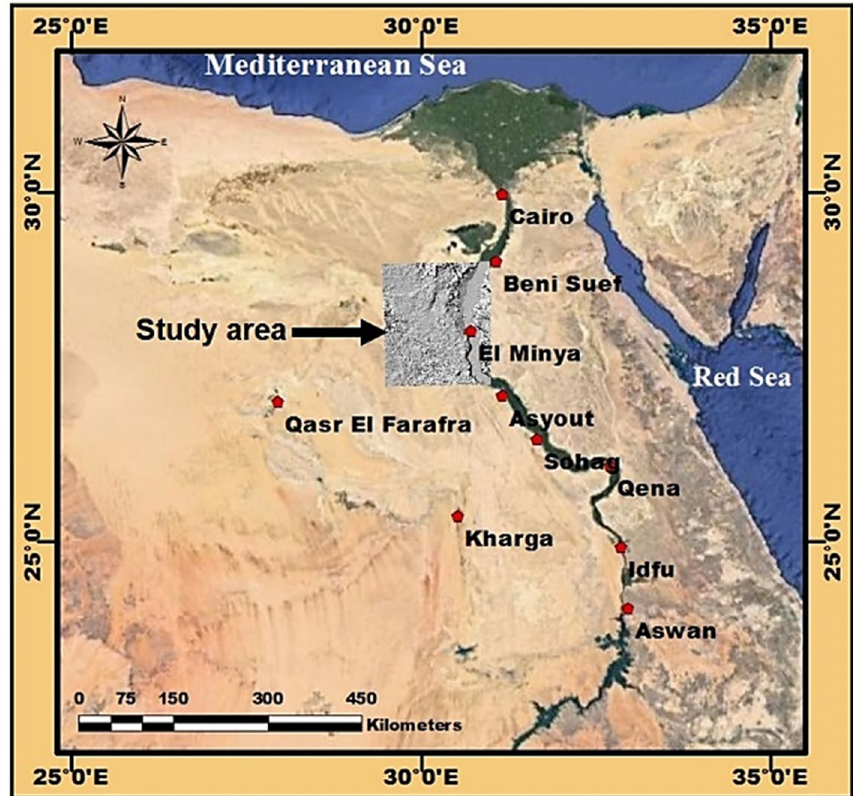
Fig. 1 Map of study site loca-